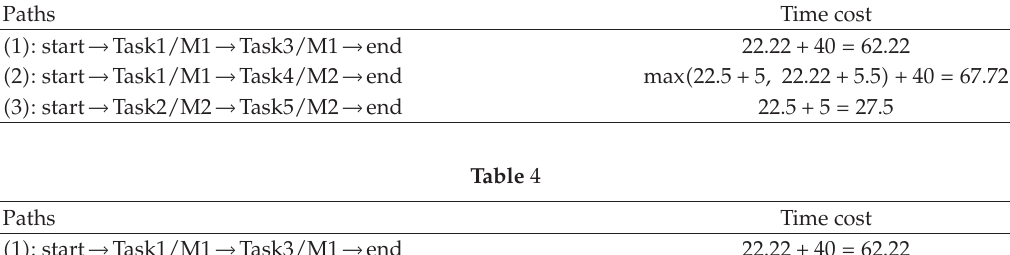
Paths Time cost (cid:3) 1 (cid:4) : start → Task1/M1 → Task3/M1 → end